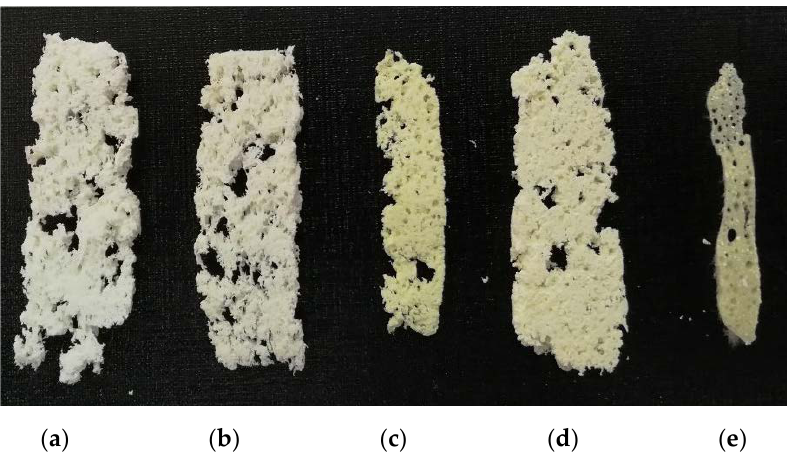
Figure 2. The slices of the obtained porous composite materials: ( a ) 1/6-70-30; ( b ) 1/4-70-30; ( c ) 1/2-70- 30; ( d ) 1/4-50-50; ( e )